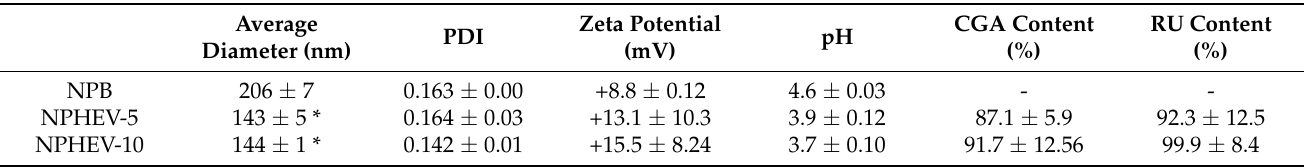
Table 1. Nanoparticle suspension physicochemical